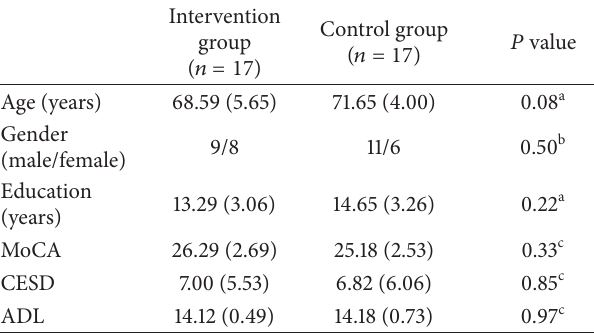
Table 1: Demographic and clinical characteristic of the participants (mean and standard